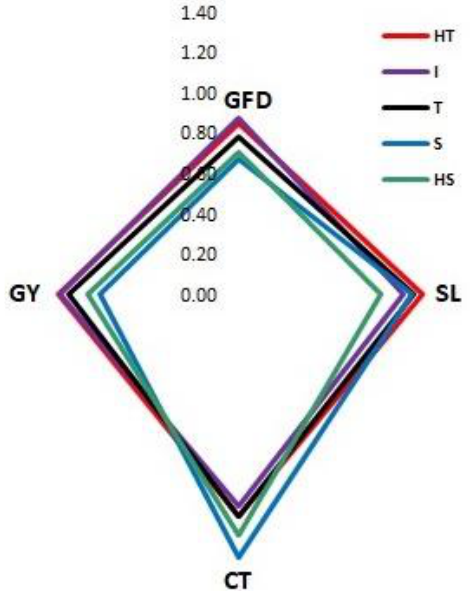
Figure 5. Radar charts comparing three indices of the five groups. Data was analyzed using least squares (LS). Grain-filling duration (GFD), canopy temperature (CT), spike length (SL), and grain yield